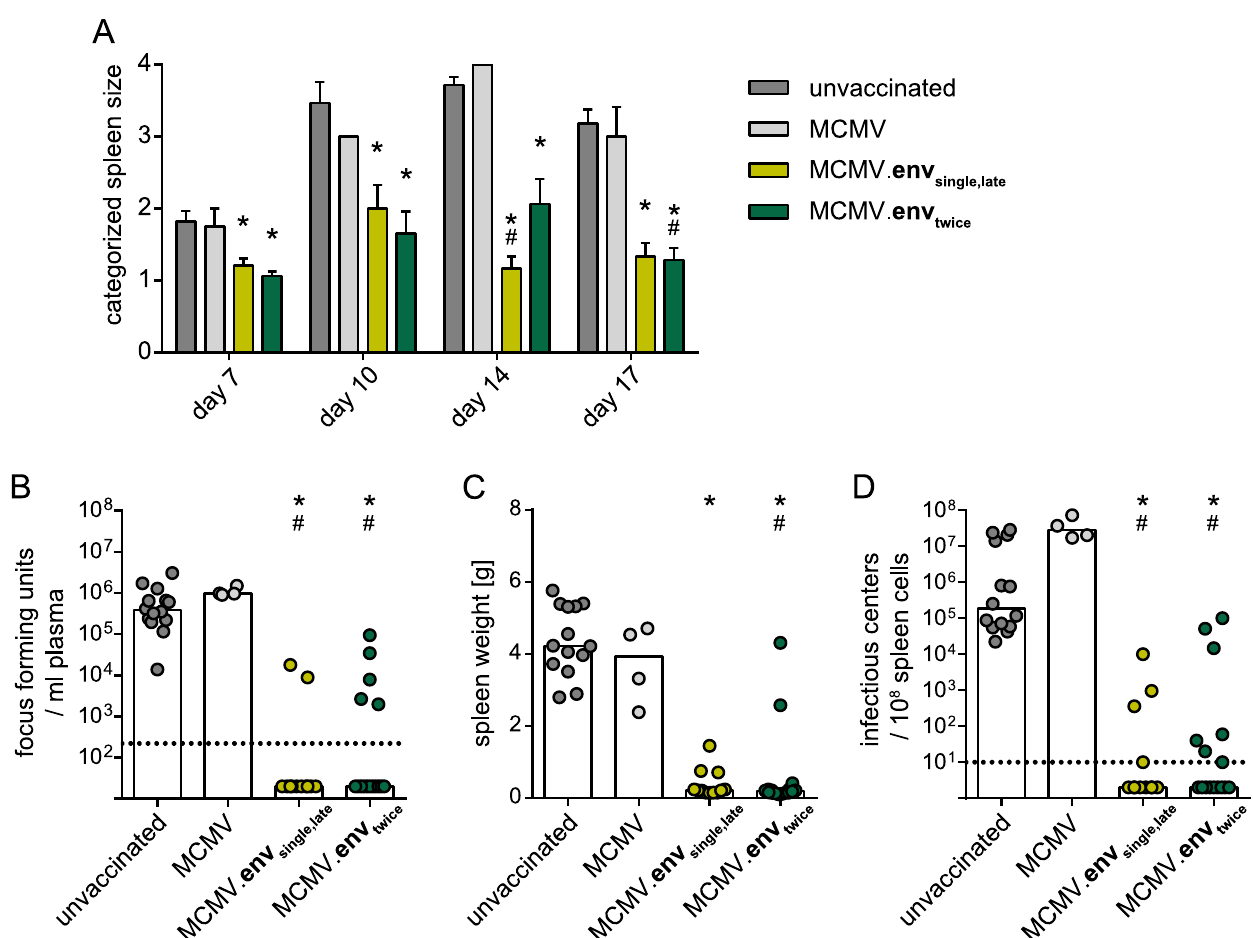
Fig 4. Strong protection from late FV challenge after single or repeat MCMV.env immunization. CB6F1 mice were immunized with MCMV.env, or a non-transgene-encoding control MCMV, either once, or twice in a three-week time interval, and infected with 5 000 SFFU FV six weeks after the first immunization. Development of splenomegaly was monitored by twice-weekly palpation of the spleens (A). Viremia levels were determined in blood samples collected 10 days after FV infection (B); spleens were isolated three weeks after FV infection and spleen weights (C) and spleen viral loads were analysed (D). Each dot indicates an individual mouse, columns indicate mean (A, C) or median values (B, D), column whiskers indicate the standard error of the means (A), dotted lines indicate the limits of detection. Data were obtained in two (MCMV), three (MCMV.env single,late ) or five independent experiments (MCMV. env twice , unvaccinated), using 4 (MCMV), 12 (MCMV.env single,late ) or 14 mice (unvaccinated, MCMV.env twice ) per group. Statistically significant differences compared to unvaccinated mice are indicated by � , significant differences compared to mice vaccinated with the MCMV control vector are indicated by # ( P < 0.05, One Way ANOVA on Ranks, Dunn’s post